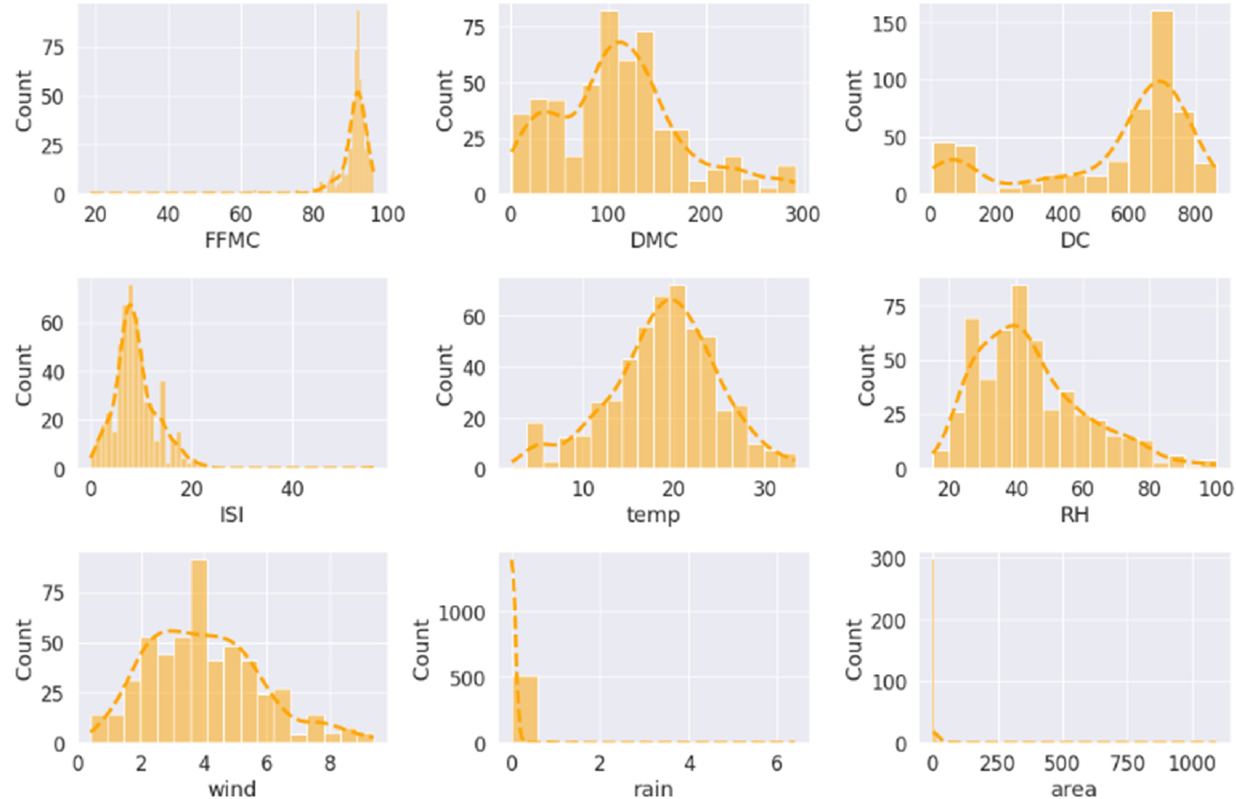
Figure 6. The continuous real-valued feature of Montesinho Natural Park.